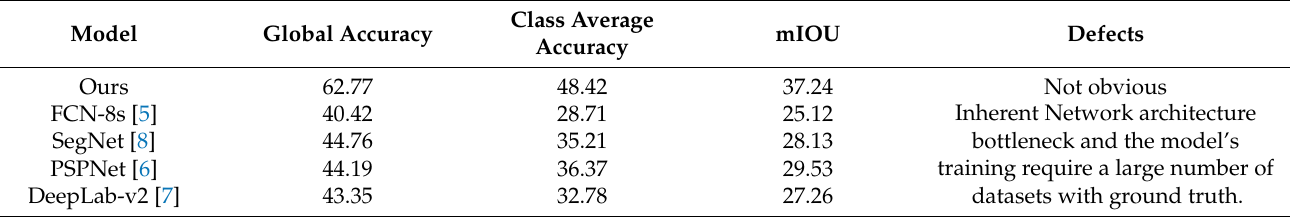
Table 8. Three commonly used performance